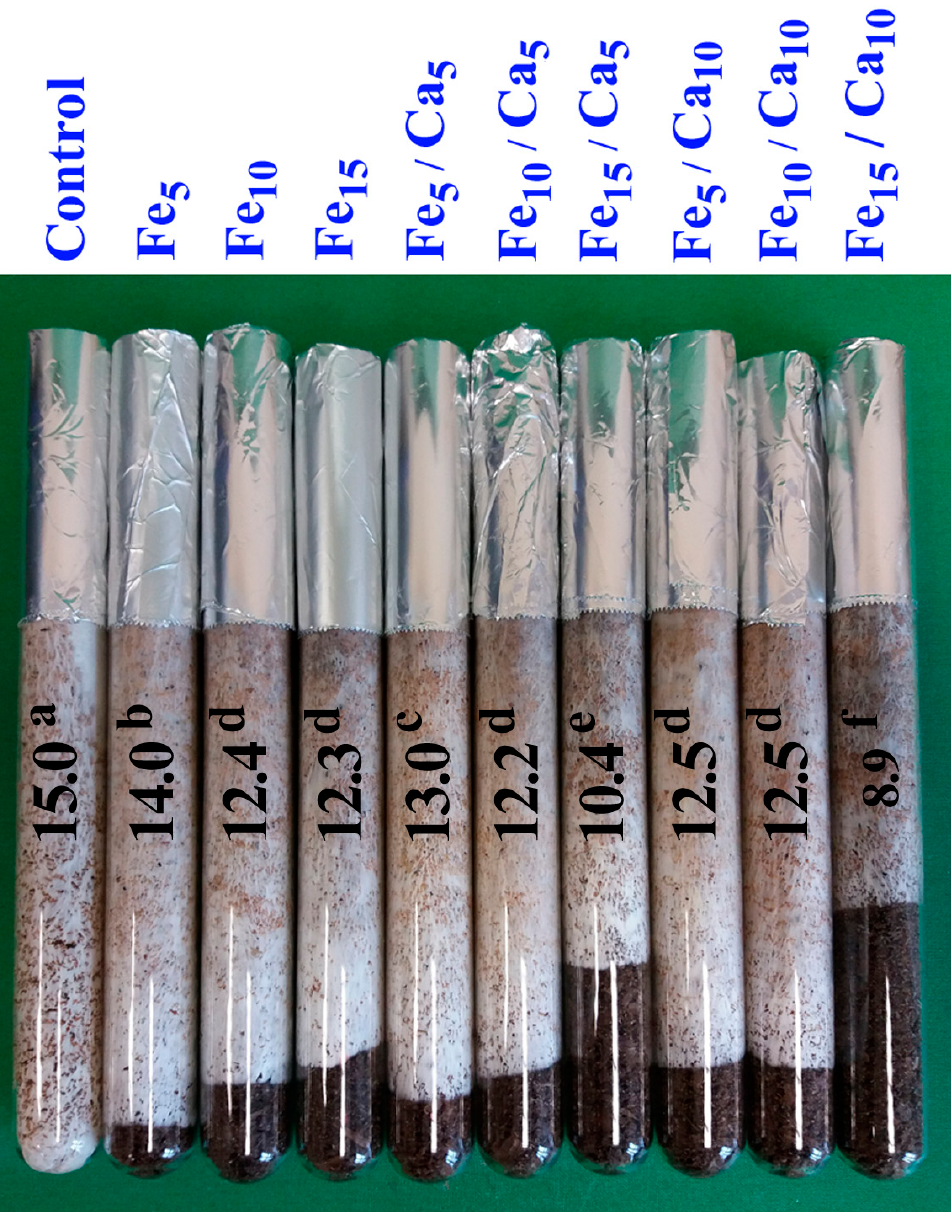
Figure 1. Characteristics of mycelium growth (cm) for particular experimental systems. n = 5, identical lower cases (a, b…) denote non-significant differences between mean Pholiota nameko growth in particular experimental systems according to post-hoc Tukey’s HSD test.